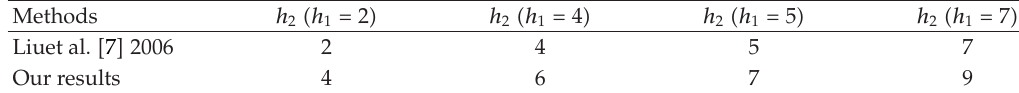
Table 1: Comparison of the maximum allowed time delay h 2 .